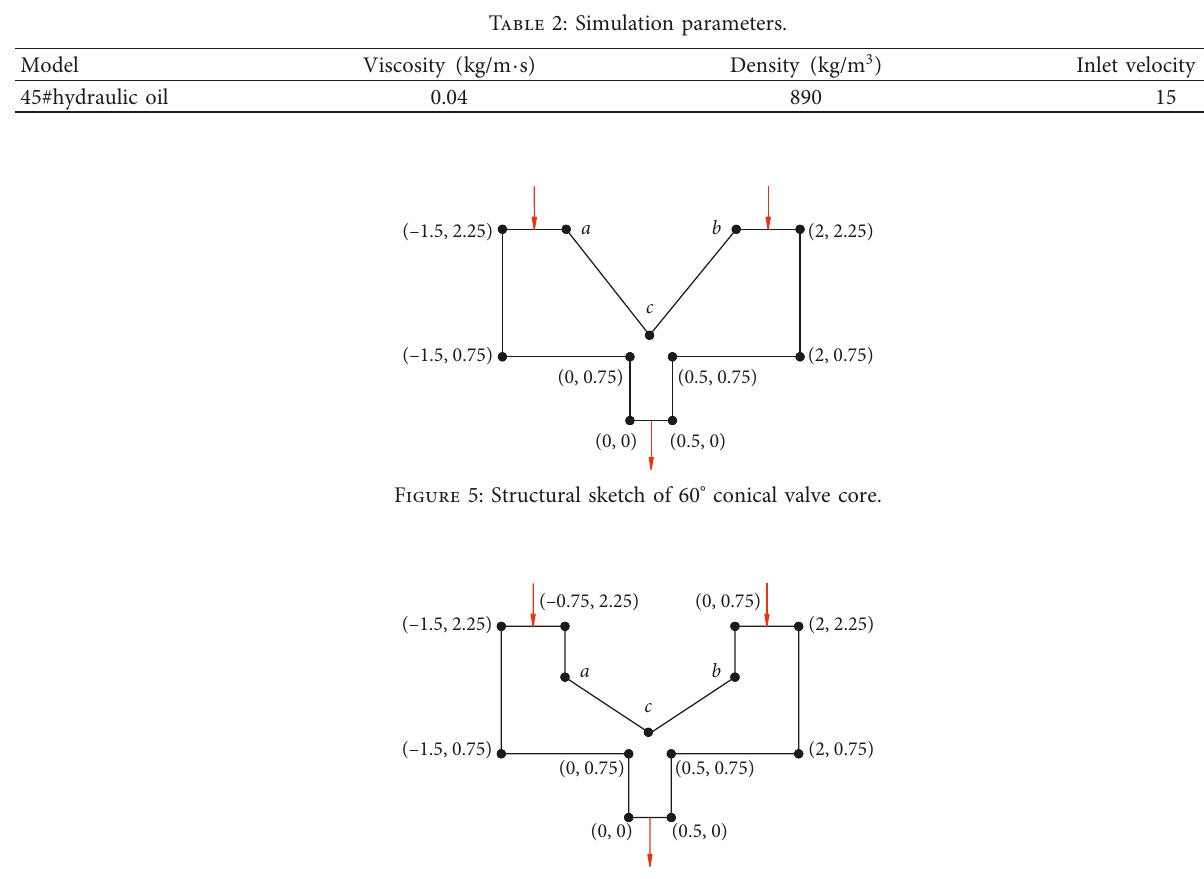
Figure 6: Structural sketch of 90 ° and 120 ° conical valve core. Table 3: Structural size of the conical spool with different angles.